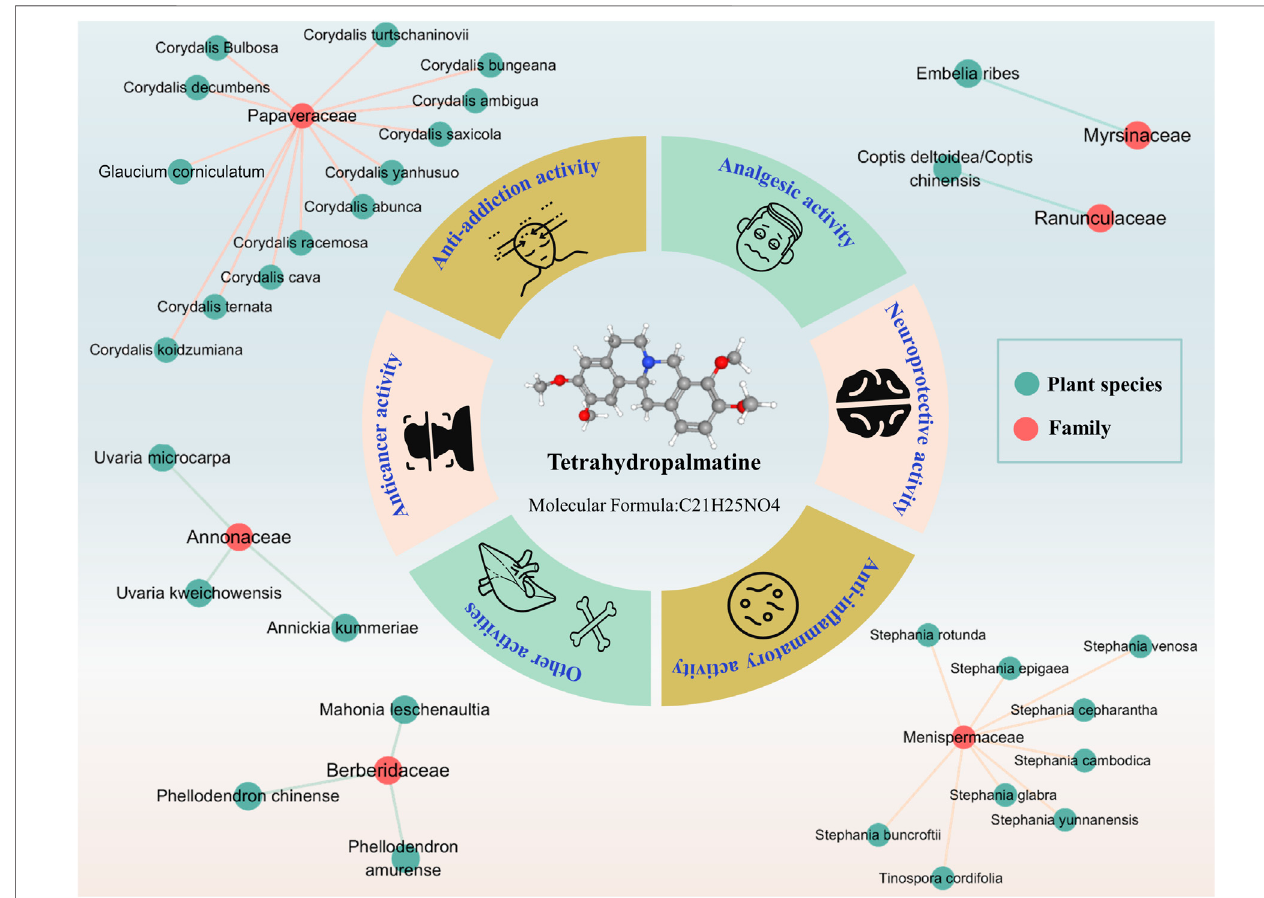
FIGURE 1 | Plant source and potential pharmacological activity of THP. (References to all information speci fi ed in the fi gure are in the Supporting materials References).